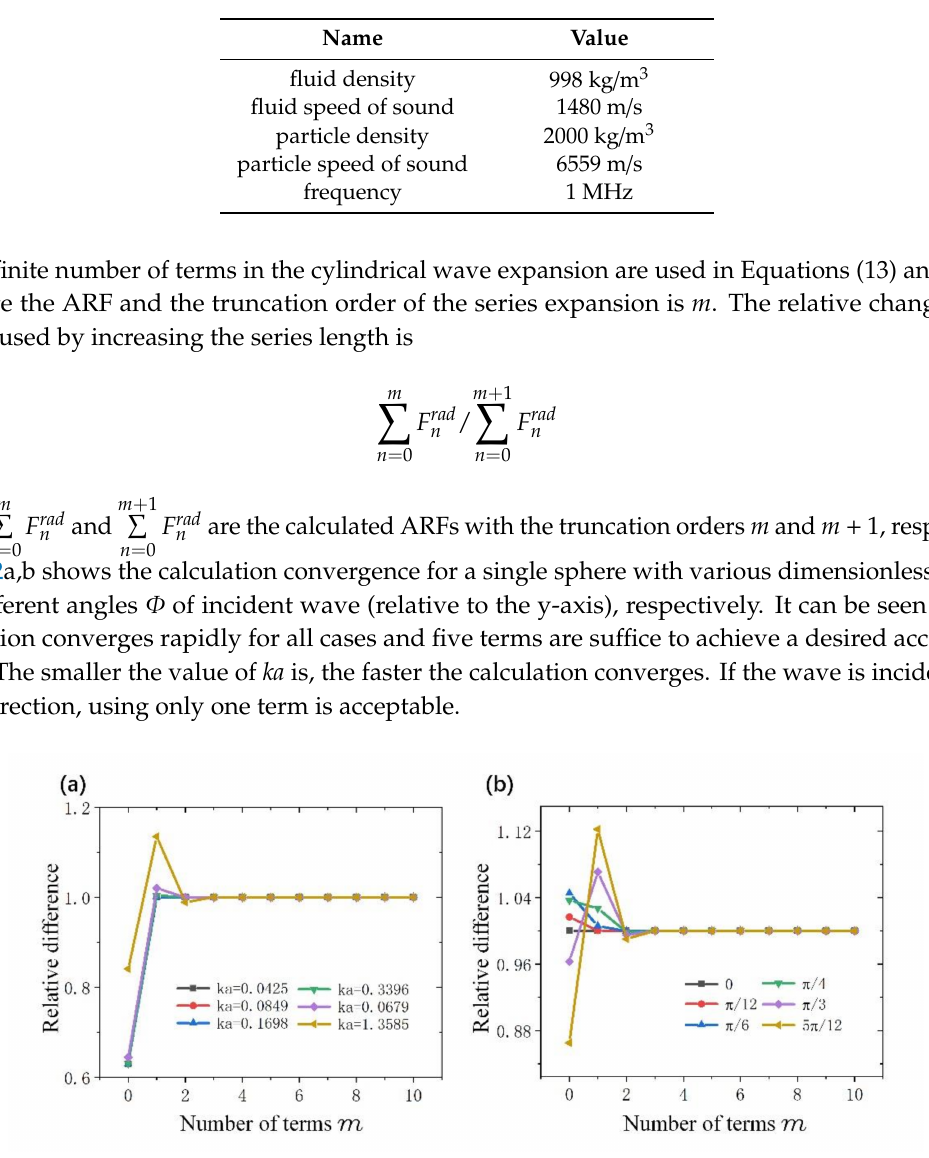
Table 1. Acoustic parameters of silica bead used in the calculation.